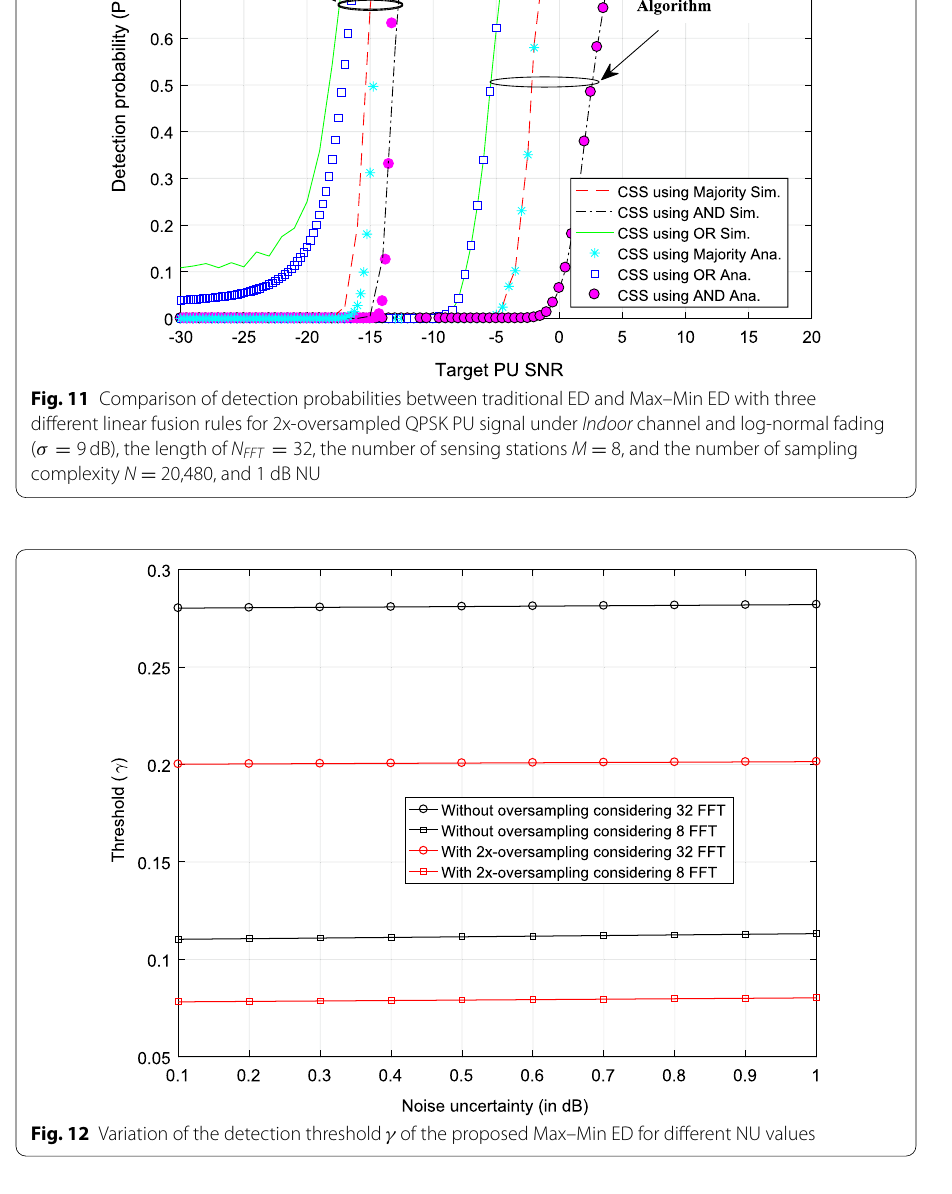
Fig. 12 Variation of the detection threshold γ of the proposed Max–Min ED for different NU